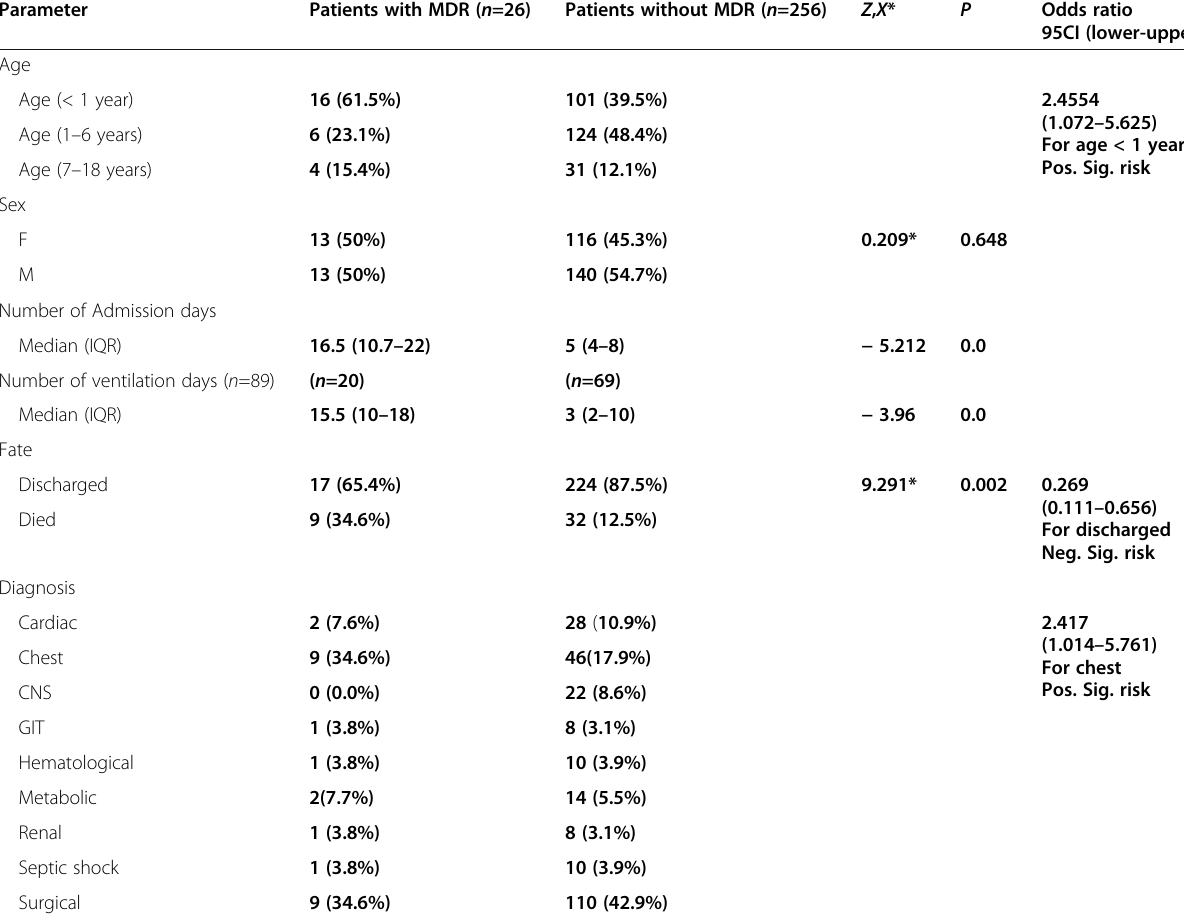
Table 4 Descriptive and comparative statistics between patients infected with MDR microorganisms and patients without infection